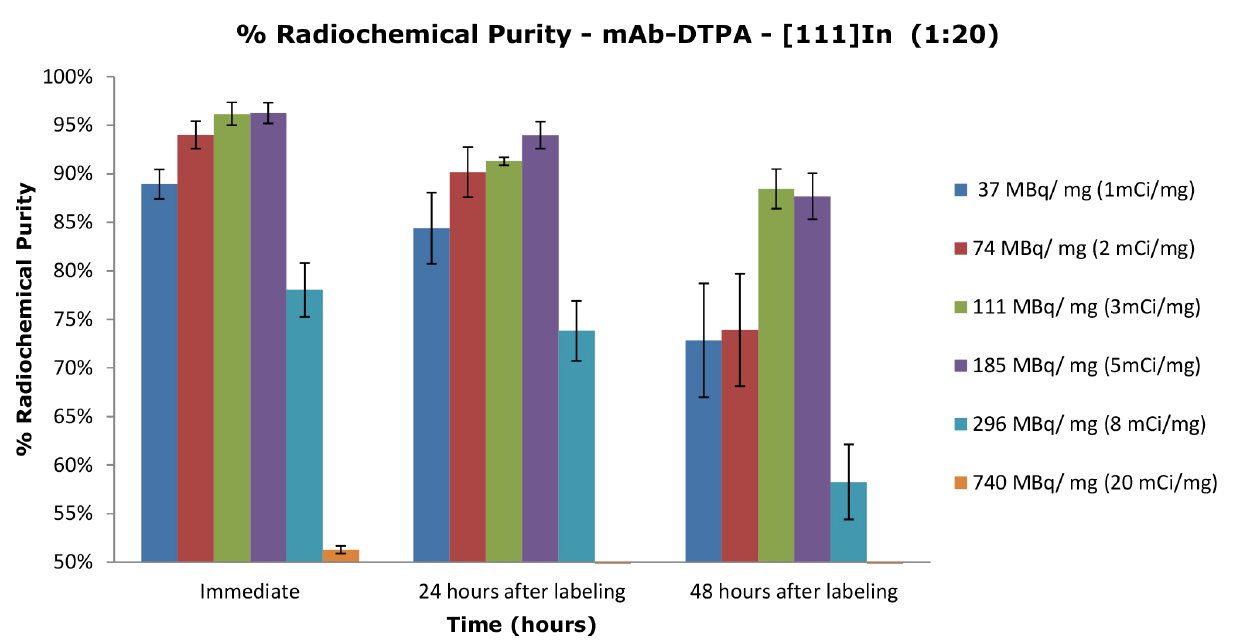
FIGURE 6 - Radioimmunoconjugate stability study (48 hours) - Radiochemical purity analysis of Cetuximab-DTPA (20:1) radiolabeled with indium-111, at different specific activities (MBq/mg). Results obtained by CCD (n ≥ 3).